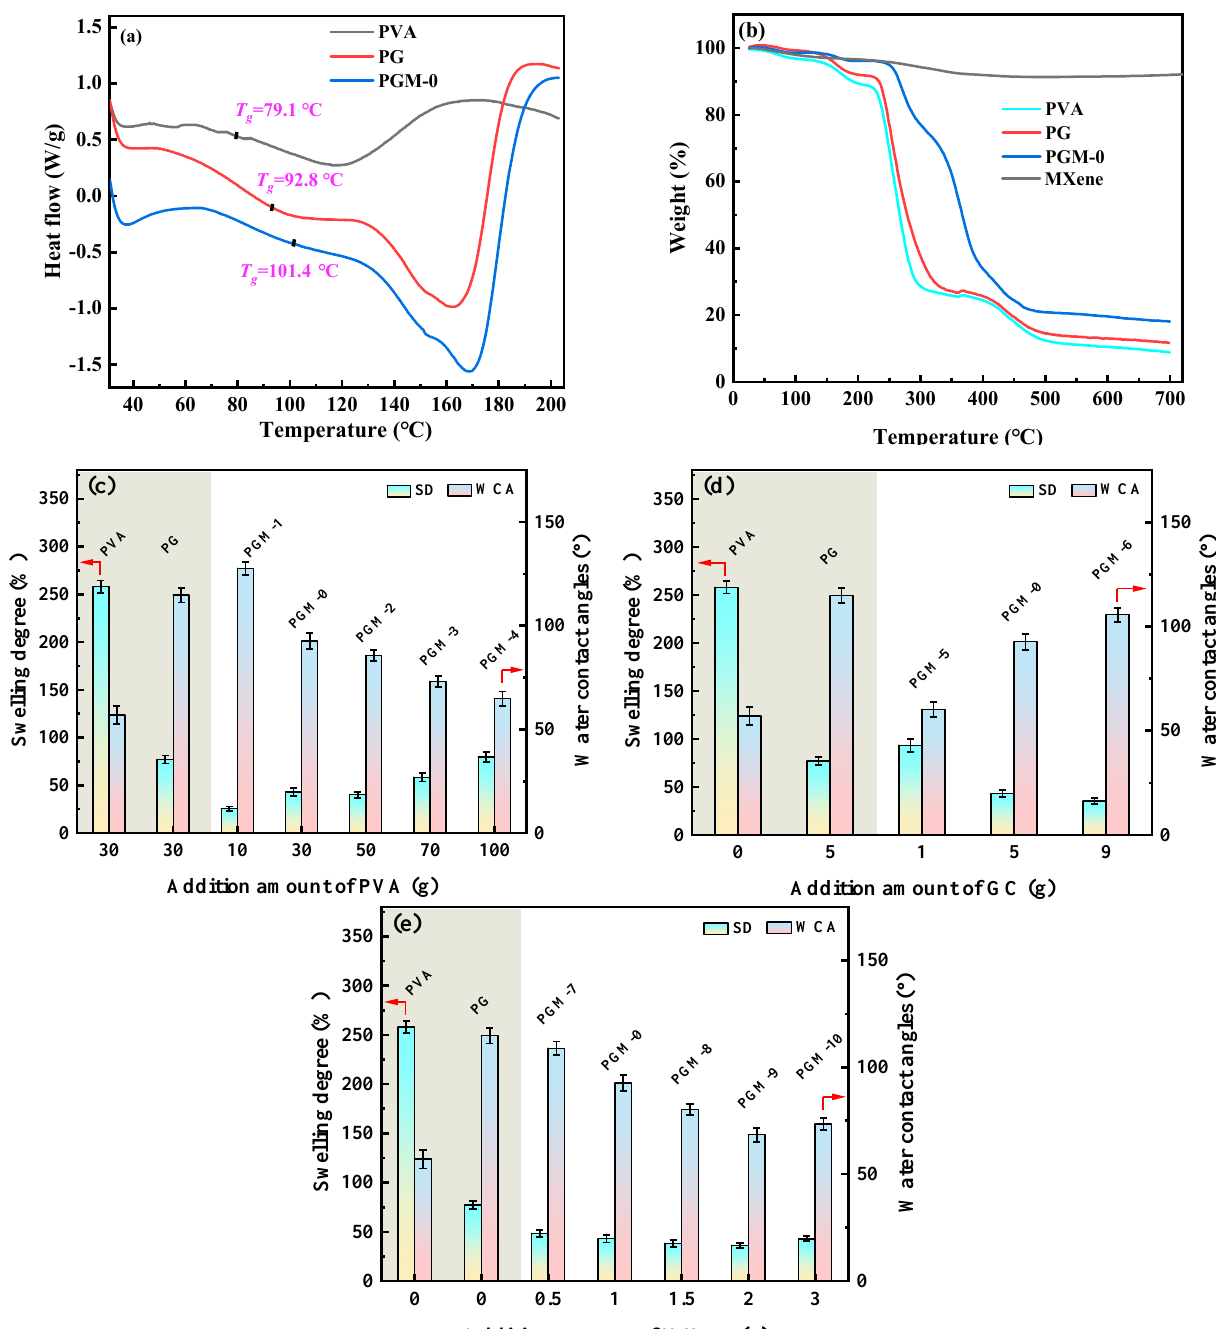
Figure 7. ( a ) DSC curves of the PVA, PG, PGM-0 membranes, ( b ) TGA curves of the PVA, PG, PGM-0 membranes and pure MXene, swelling ratios and water contact angles of the PVA MMMs with different addition amount of the ( c ) PVA, ( d ) GC and ( e ) MXene listed in Table 1.